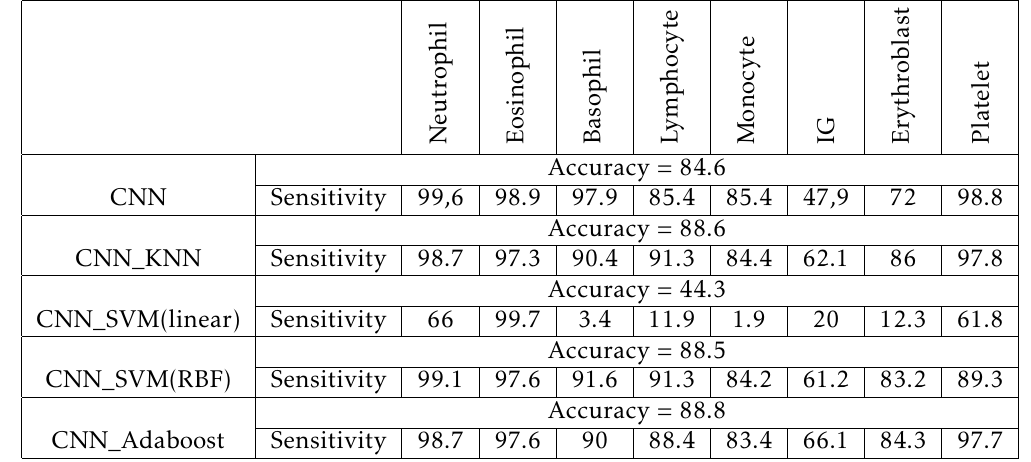
Table 2. Comparison between CNN, CNN_KNN, CNN_SVM (Linear), CNN_SVM (RBF) and